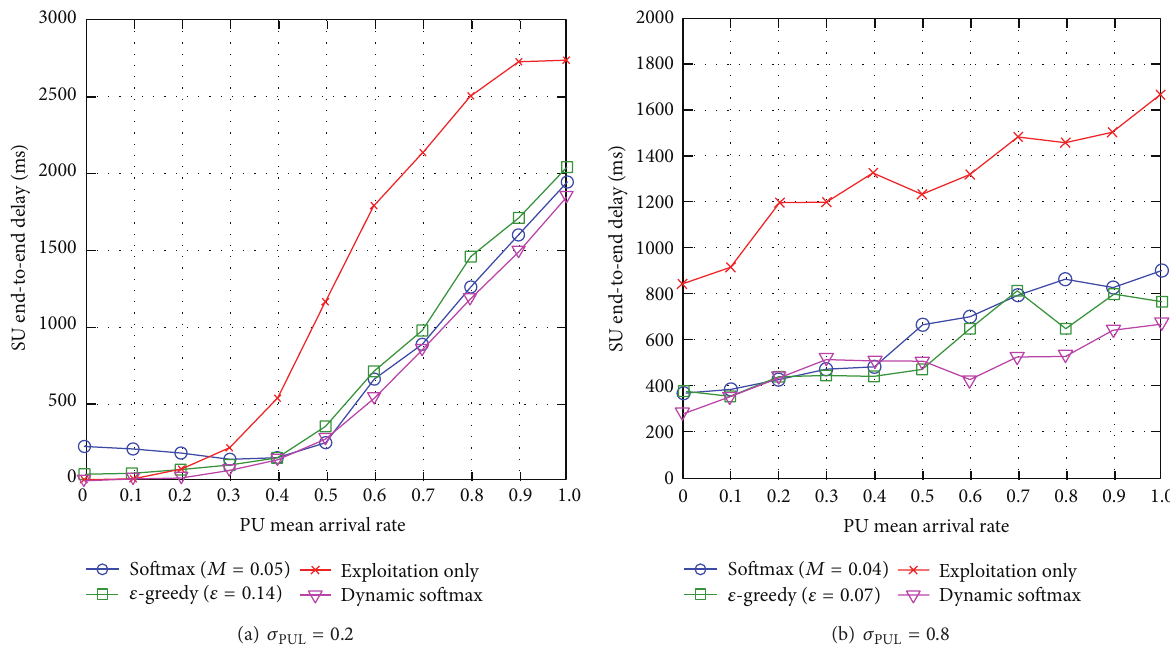
Figure 12: SU end-to-end delay for varying PU mean arrival rate 𝜇